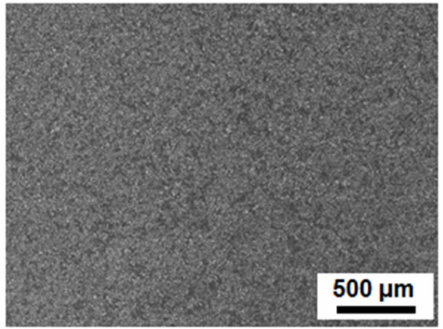
Figure 6. The SEM micrograph of the commercial Cu-W